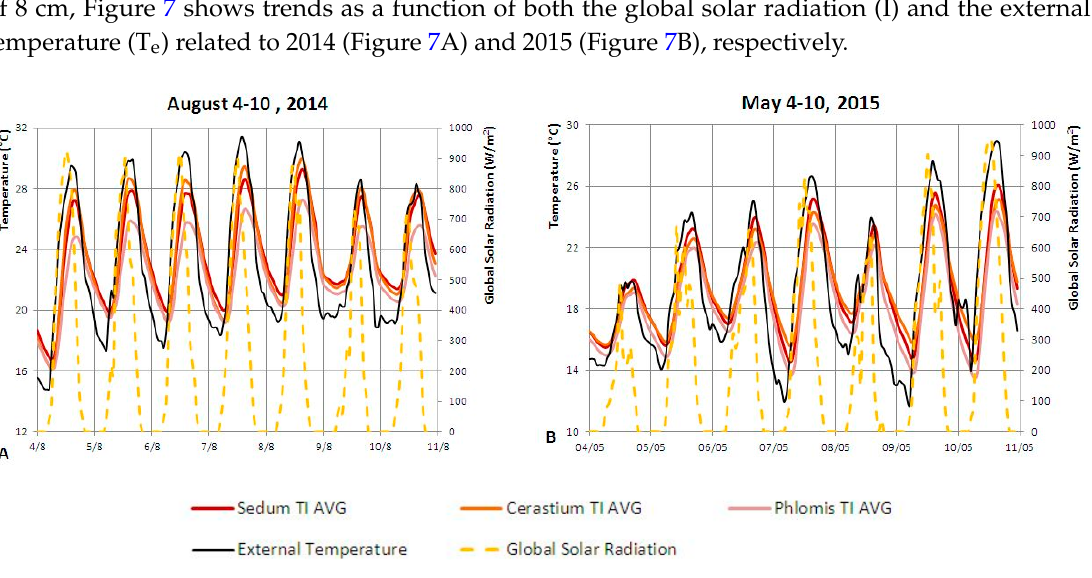
Table 4. Thermal gradients between paved surface T sfloor , plots T s and T i .